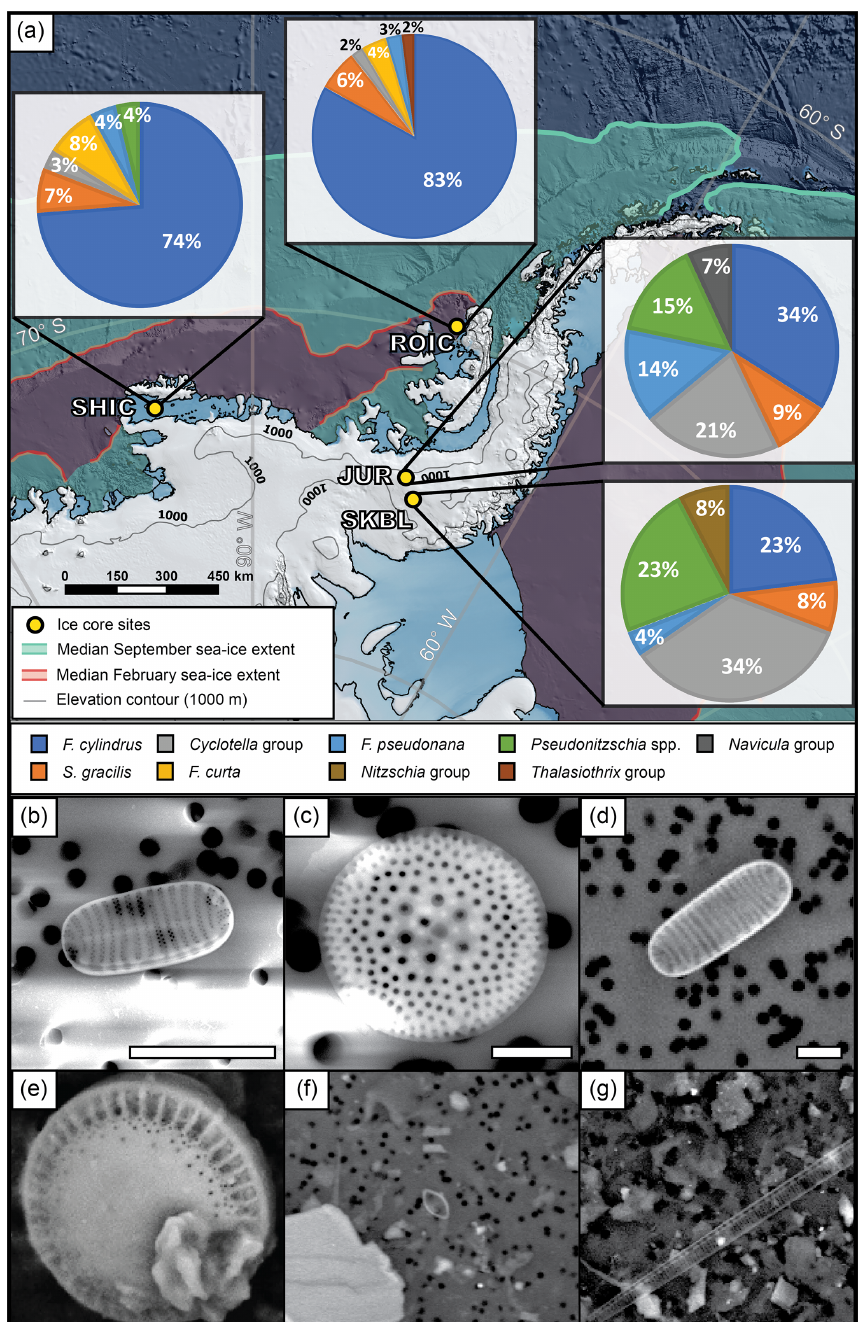
Figure 6. Main diatom assemblage for each ice core over their overlapping period (2002–2006CE). (a) Map of ice core sites showing the main diatom assemblage for each location. Scanning electron microscope (SEM) micrographs of the most abundant diatom taxa. (b) F. cylindrus found in ROIC. (c) S. gracilis found in JUR. (d) F. curta found in SHIC. (e) Diatom valve as an example of the Cyclotella group found in JUR. (f) F. pseudonana found in JUR. (g) Pseudonitzschia spp. found in SKBL. Scale bar in bottom right of each frame represents